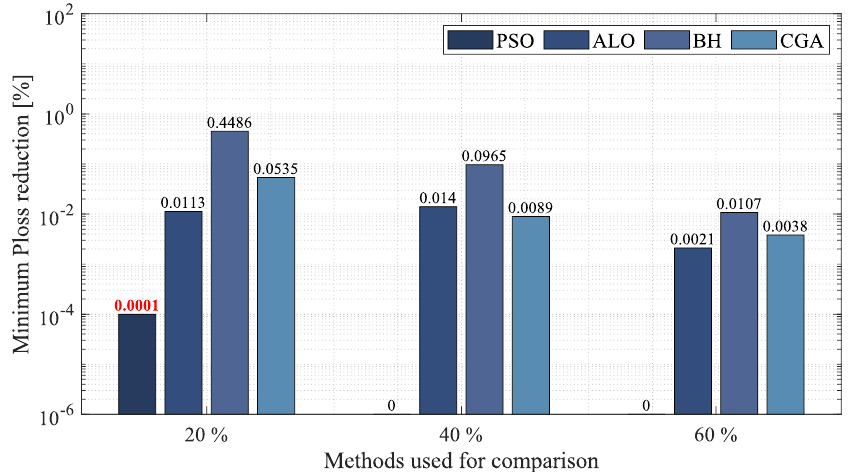
Figure 6. Percentage of reduction of minimum power losses obtained by the MVO in the 10-node radial test system compared to other